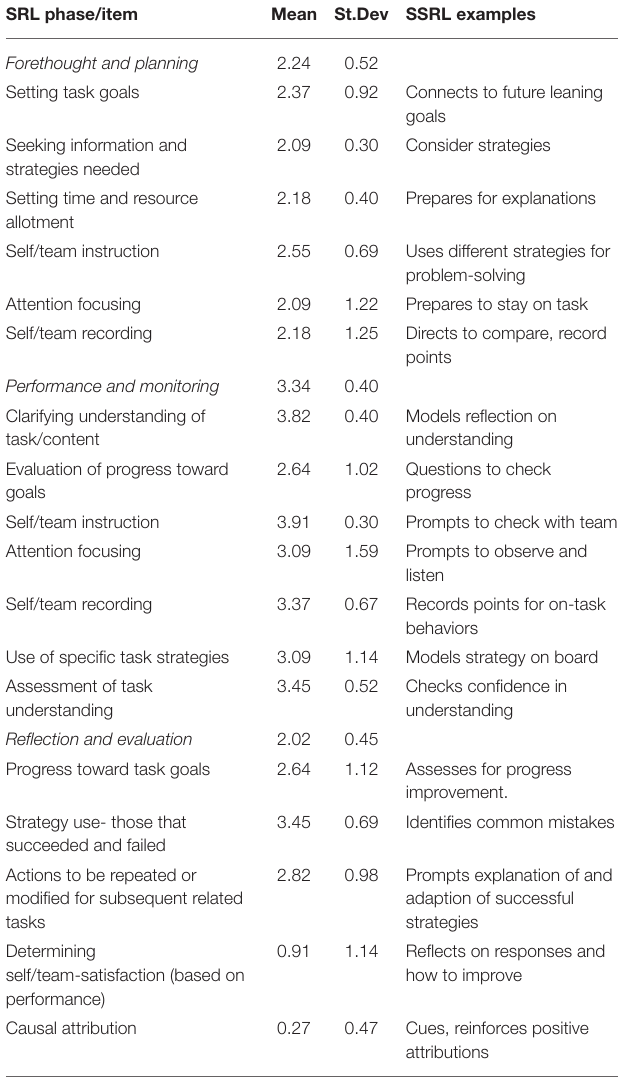
TABLE 1 | Teacher observation scores and example behaviors ( n =